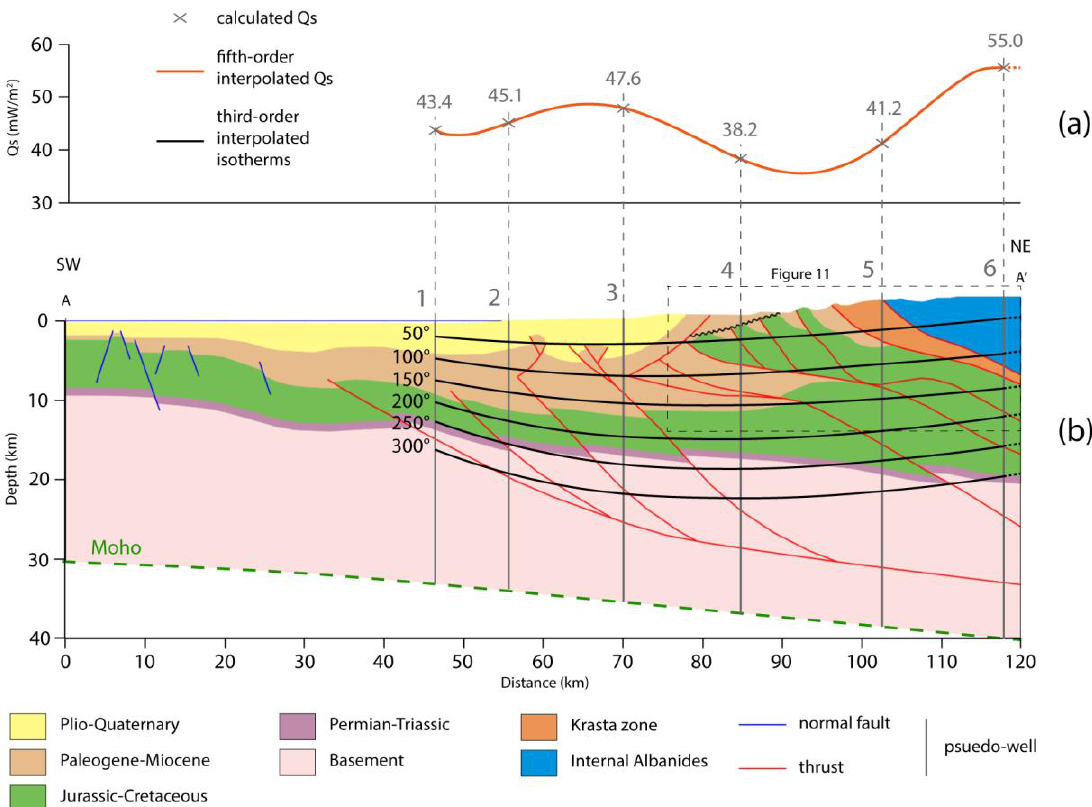
Figure 8. ( a ) Calculated surface heat flow ( Q s ) using the seven pseudo-wells. Grey crosses show not interpolated values, the orange curve was obtained using an interpolation by a fifth-order polynomial equation. ( b ) Thermal structure of the outer Albanides and adjacent Adriatic o ff shore as defined by isotherms produced by a third-order polynomial equation among pseudo-wells. The dashed rectangle shows location of the “Kruja geothermal zone”.